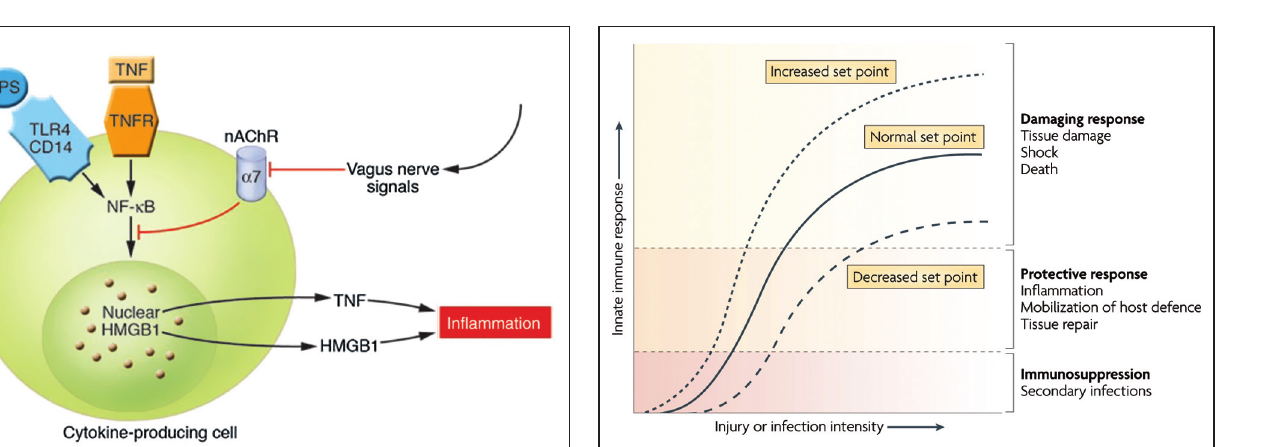
FIGURE 3 | Cholinergic signals derived from vagus nerve stimulation inhibit the release of TNF- α , IL-1, HMGB1, and other cytokines by transducing a cellular signal that inhibits the nuclear activity of NF- κ B . TNFR stands for TNF receptor (Wang et al., 2004; Tracey, 2007). The cytokine producing cell can be a macrophage, among others. The nAChR family are ligand-gated ion channels that mediate diverse physiological functions and were originally identified in the nervous system. They consist of different subtypes formed by the specific assembly of five polypeptide subunits including α 1-10, β 1-4, γ , δ , and (cid:6) . The subunits fall into two groups: neuronal nicotinic receptors (consisting of α 2–10 and β 2–4) and muscle nicotinic receptors (consisting of α 1, β 1, γ , δ , and (cid:6) ). Functional neuronal nAChR subtypes are either homomeric (consisting of 5 identical α -subunits, as in α 7- or α 9 nAChR) or heteromeric (consisting of combinations of the α - and β -subunits, such as α 3 β 2nAChR) (Yeboah et al.,